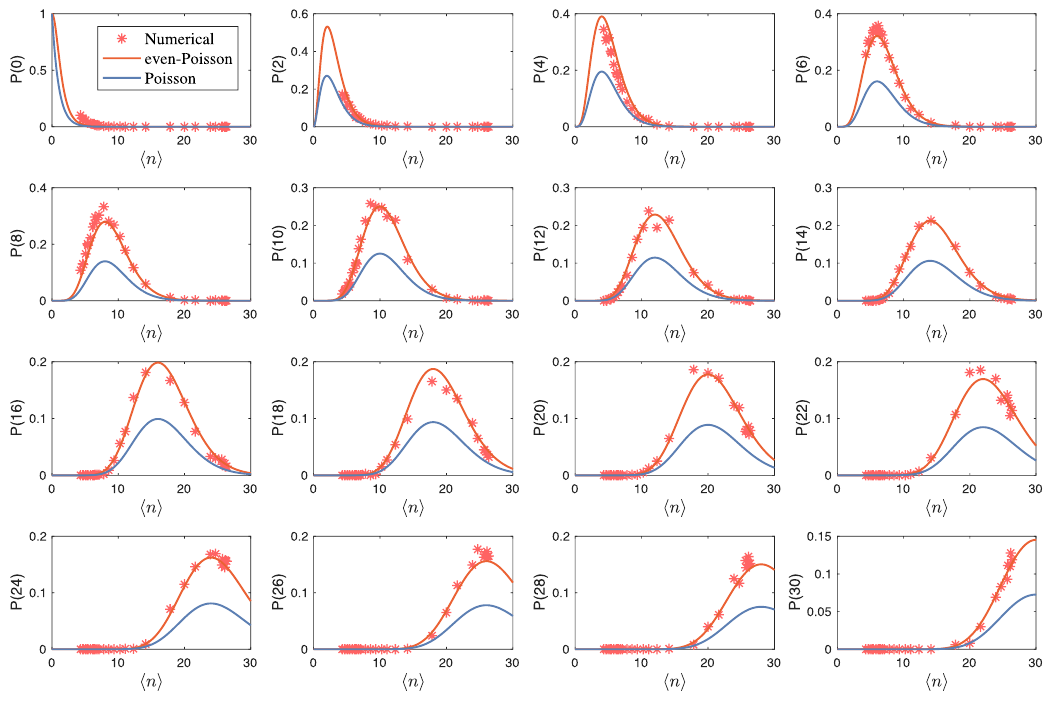
Figure 8 . Probability distribution of each even appearance of vortices P ( n = 0 , 2 , 4 , . . . , 30) with respect to the average vortex number h n i . Except for n = 0 , other distributions P ( n ) satisfy the EP distribution very